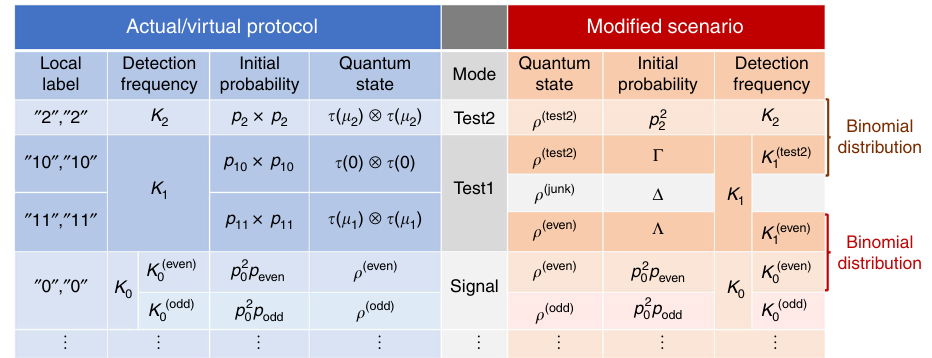
Fig. 2 Relation between the actual/virtual protocol and the modi fi ed scenario. Each row is chosen with the initial probability and the pulse pair is prepared in the corresponding quantum state. The detection frequency is the number of times Charlie has declared success. The cases when Alice ’ s and Bob ’ s label differ are irrelevant and not shown. In the actual protocol, three detection frequencies, K 0 , K 1 , and K 2 are determined. In the virtual protocol, K K ð even Þ and K ð odd Þ . The security of the actual protocol is quantitatively assured if a good upper bound on 0 is decomposed into a sum of two frequencies, 0 0 K ð even Þ is found. To fi nd such a bound, we consider a modi fi ed scenario in which the variables ð K ; K ; K ð even Þ follows the same statistics as in the virtual 2 1 0 Þ protocol. In the modi fi ed scenario, K 1 is interpreted as a sum of three frequencies corresponding to three different initial quantum states of the pulse pair, ρ ð test 2 Þ , ρ ð junk Þ , and ρ ð even Þ . We notice that the fi rst two rows are chosen with probabilities p 2 and Γ and classi fi ed to the Test2 mode and to the Test1 2 mode accordingly, but the pulse pairs are initially prepared in the same state ρ ð test 2 Þ . Charlie ’ s success/failure declaration and the Test2/Test1 mode